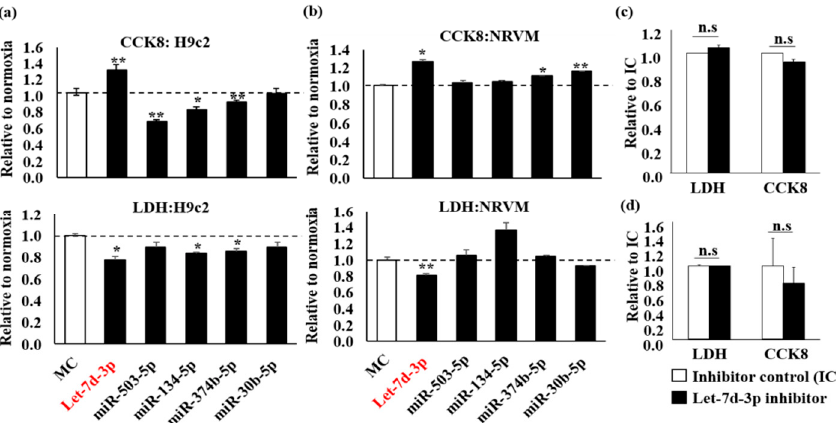
Figure 1. Functional screening of miRNA targets in H9c2, rat cardiomyoblast cells, and